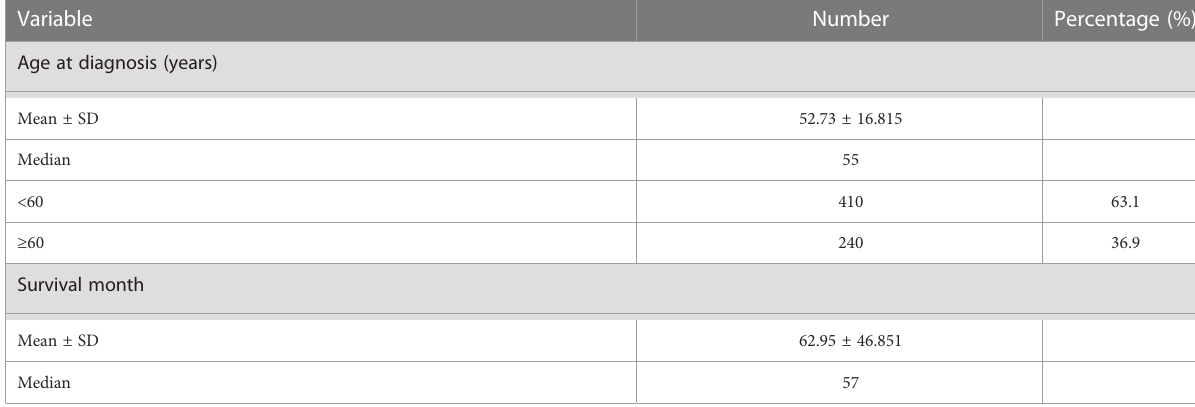
TABLE 1 The demographic characteristics, treatment, and follow-up of these patients with CNS solitary fi brous tumors.